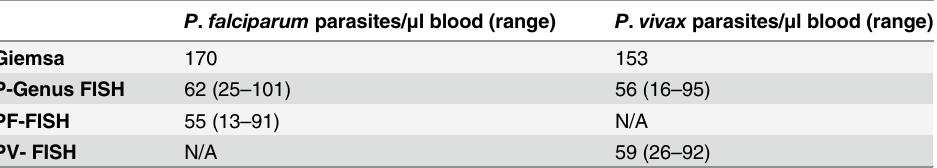
Table 1. Lowest number of parasites detected per μ l blood by Giemsa and FISH. N/A — not applicable.